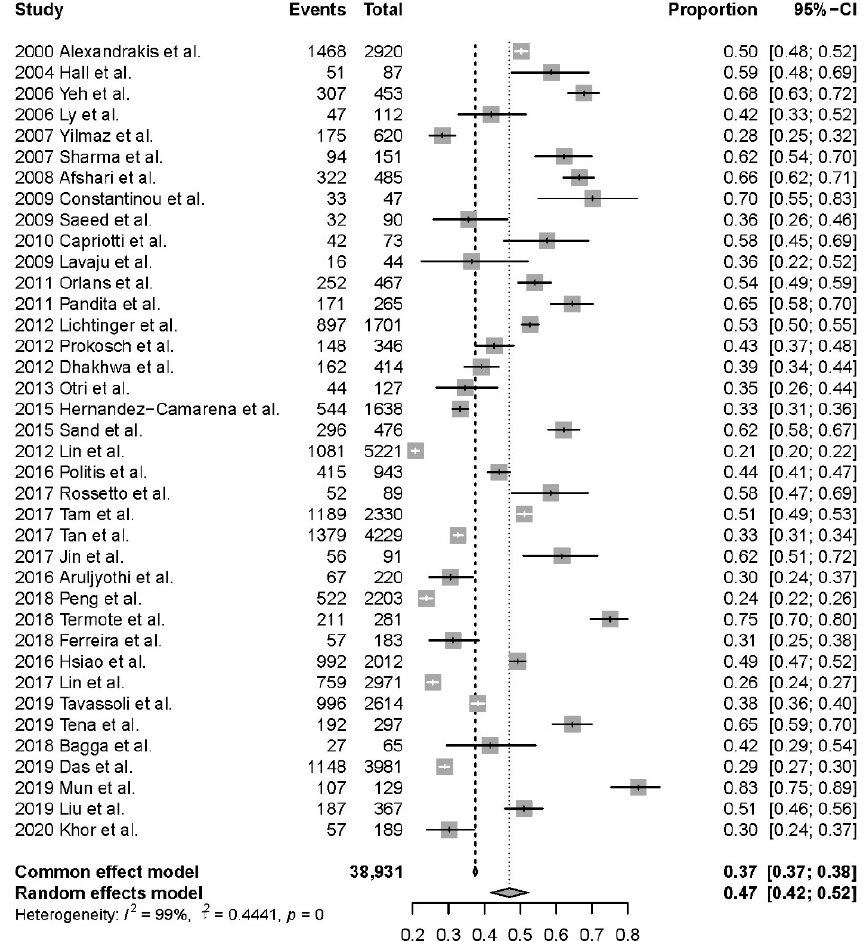
Figure 2. Analysis of positive rate of bacterial culture (38 studies).